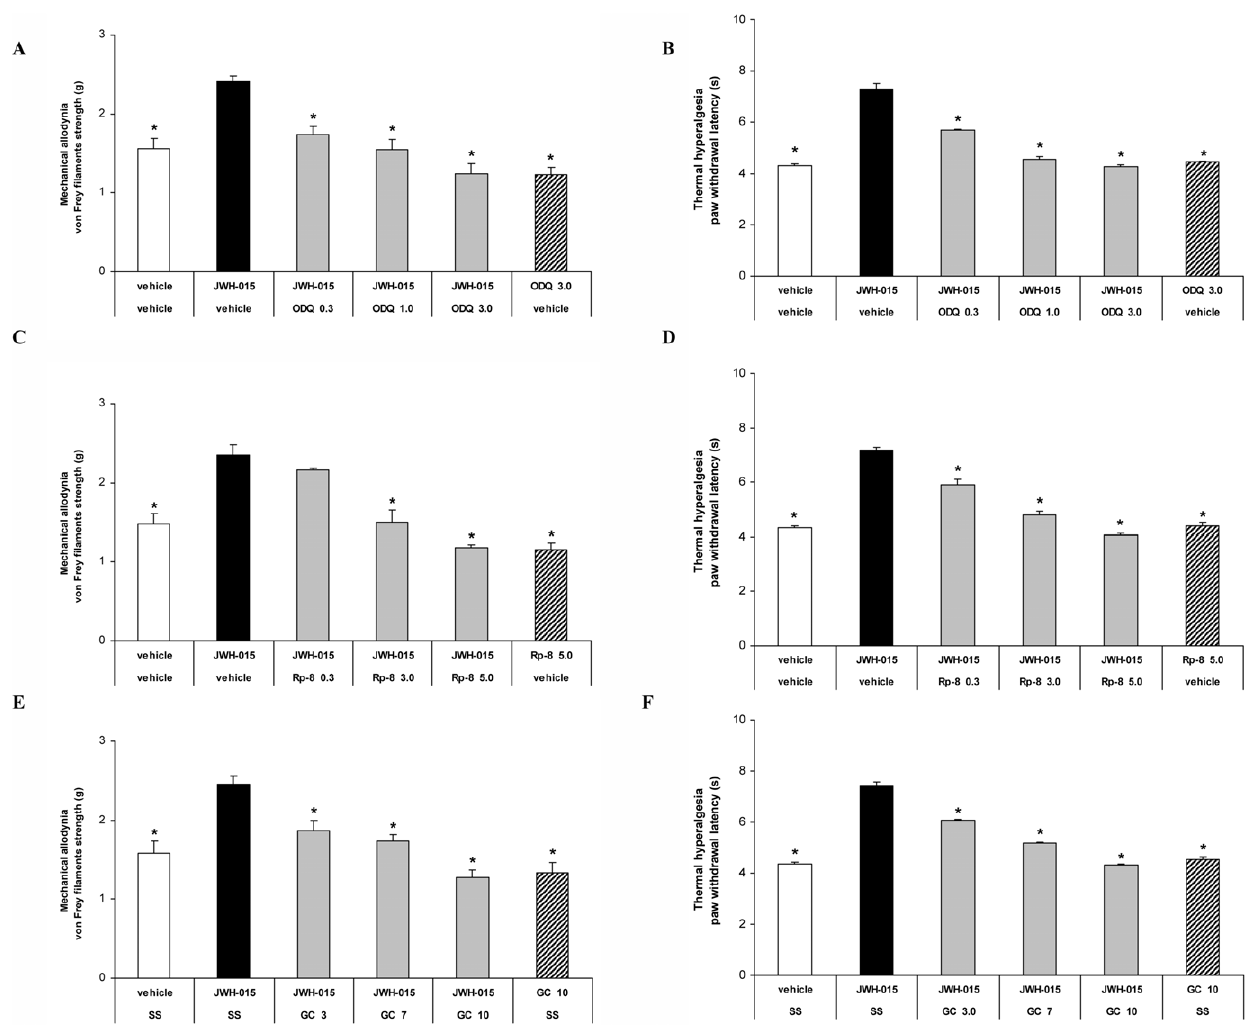
Figure 6. The role of the peripheral nitric oxide–cGMP–PKG-KATP signaling pathway in the antinociceptive effects of JWH-015. Mechanical antiallodynic (A, C, E) and thermal antihyperalgesic (B, D, F) effects of the subplantar co-administration of JWH-015 (150 m g) plus vehicle or different doses of ODQ (0.3 – 3.0 m g; A, B), Rp-8-pCPT-cGMPs (Rp-8; 0.3-5.0 m g; C, D) or glibenclamide (GC; 3.0–10 m g; E,F) in the ipsilateral paw of WT mice at 10 days after CFA injection. The effects of the subplantar administration of vehicle and the maximal doses of ODQ (3.0 m g), Rp-8 (5.0 m g) or glibenclamide (10.0 m g) administered alone are also shown. All drugs were administered 20 min before starting behavioral testing. Data are expressed as mean values of the von Frey filaments strength (g) for mechanical allodynia and as the paw withdrawal latency (s) for thermal hyperalgesia 6 SEM (5–6 animals per group). For each behavioral test and selective inhibitor assayed, * p , 0.05 denotes significant differences vs. group treated with JWH-015 + vehicle (one way ANOVA followed by Student Newman Keuls